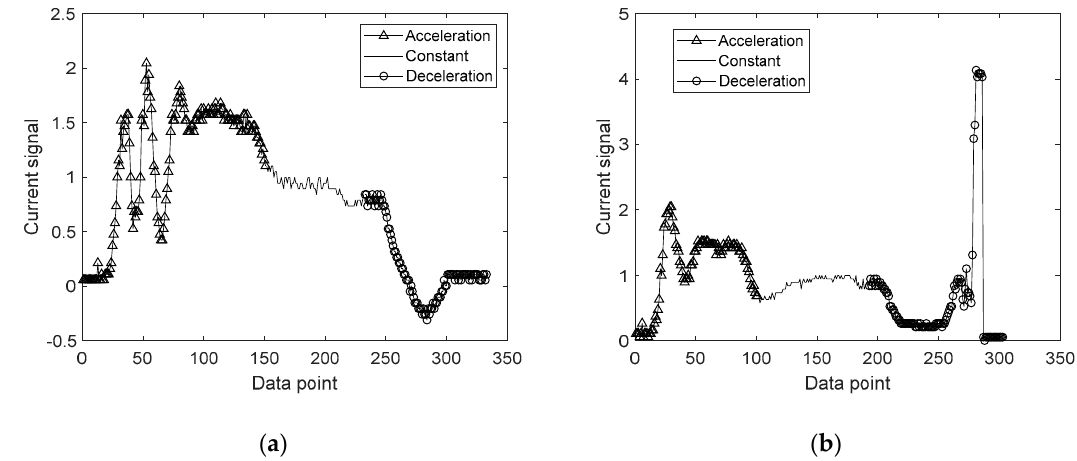
Figure 3. Current signal behavior: ( a ) open operation; ( b ) current signal during close operation.